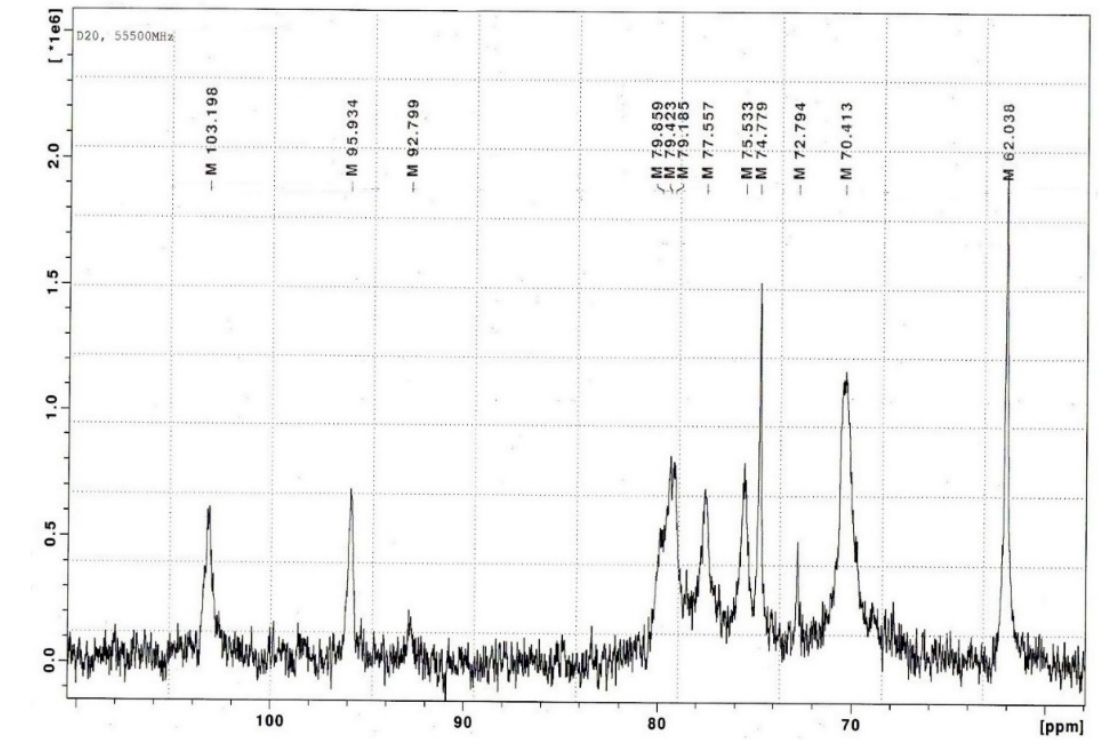
Figure 2. 13 C-NMR- spectrum of κ -CRG from C. armatus .